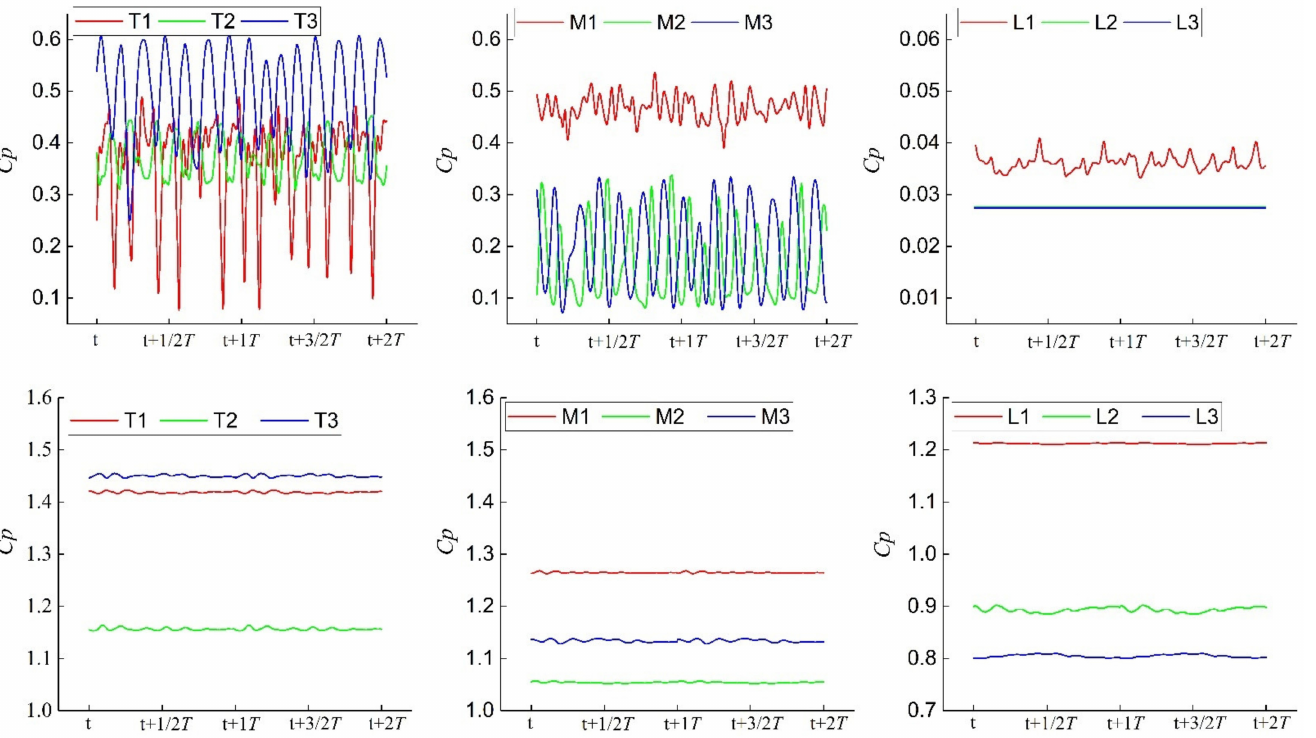
Figure 13. Comparison of pressure fluctuation curves at different monitoring points for the cavitating case ( upper ) and non-cavitating case ( lower